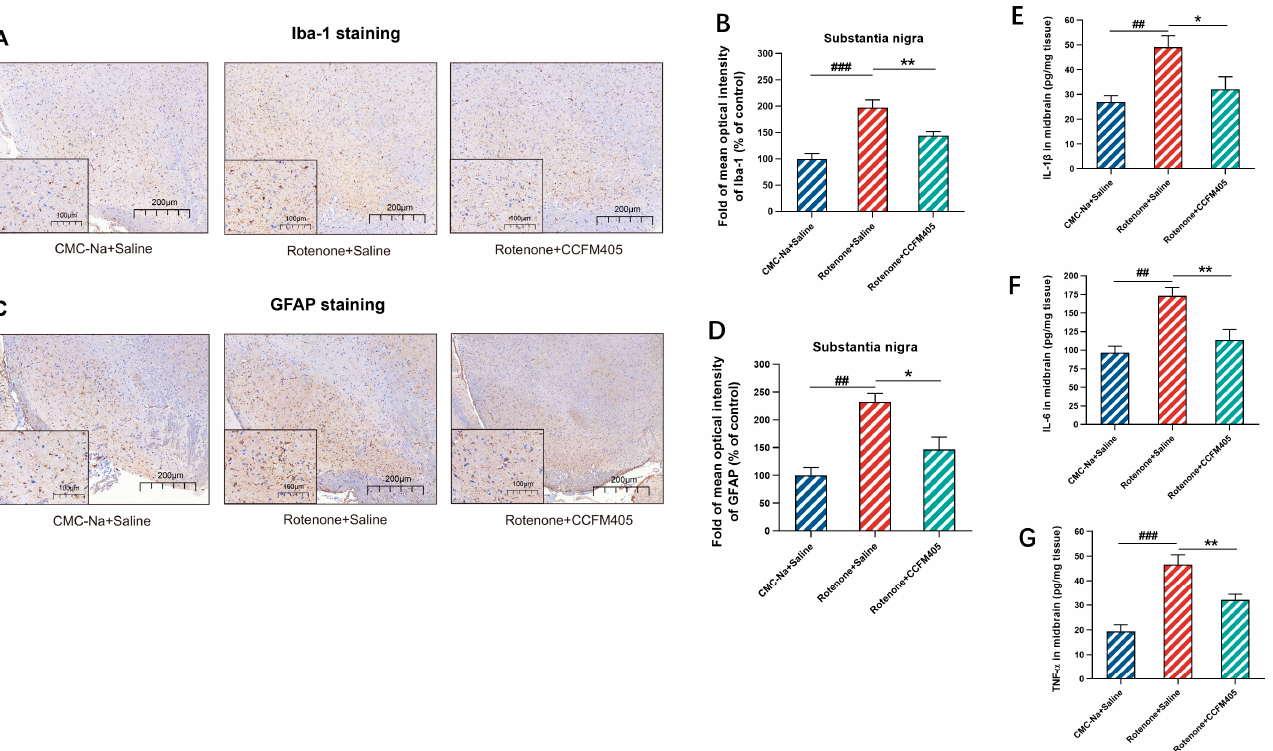
Figure 4. Effects of L. plantarum CCFM405 on microglia and astrocytes in the SN region of the brain in rotenone-challenged PD mice. ( A ) Representative images of Iba-1 immunohistochemistry in the SN of mouse brain; Scale: 200 μ m. ( B ) Average optical density analysis of Iba-1 positive cells in the SN region of mouse brain ( n = 3/group); ( C ) representative images of GFAP immunohistochemistry in the SN of mouse brain; Scale: 200 μ m. ( D ) Average optical density analysis of GFAP positive cells in the SN of mouse brain; Scale: 200 μ m ( n = 3/group); ( E – G ) the concentration of IL-1 β , IL-6 and TNF- α in the midbrain of PD mice ( n = 8/group). Data are means with SEM. ## p < 0.01, ### p < 0.001 signs Rotenone+Saline group vs. CMC-Na+Saline group; * p < 0.05, ** p < 0.01, signs Rote-